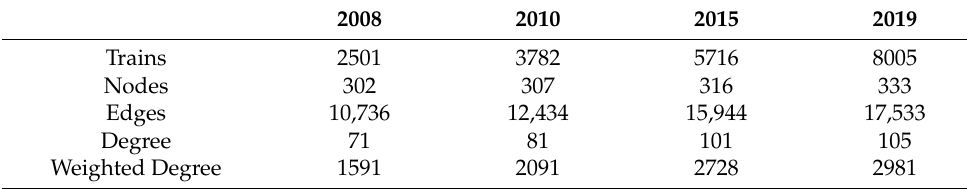
Table 3. The feature index values of the geographical railway